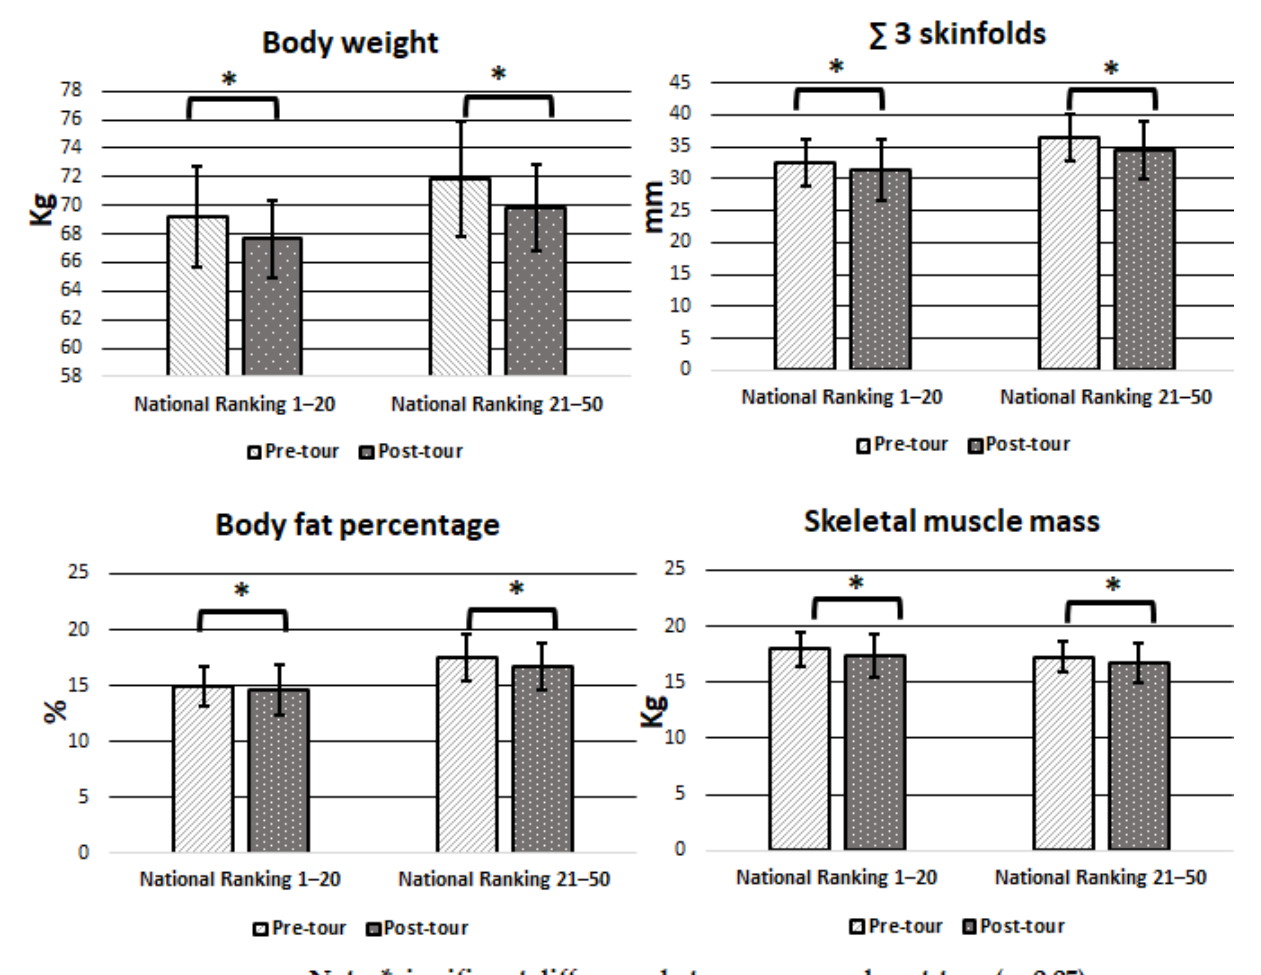
Figure 1. Mean and SD in pre- and post-tour body composition and anthropometric measures by Chilean junior tennis ranking.